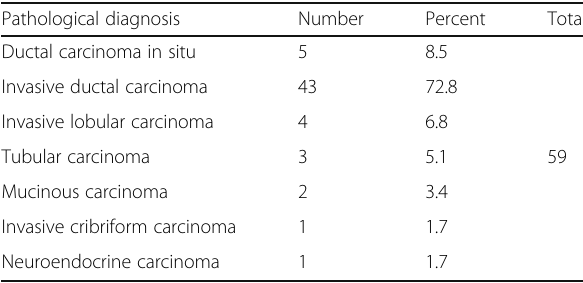
Table 2 The distribution of pathological diagnosis Pathological